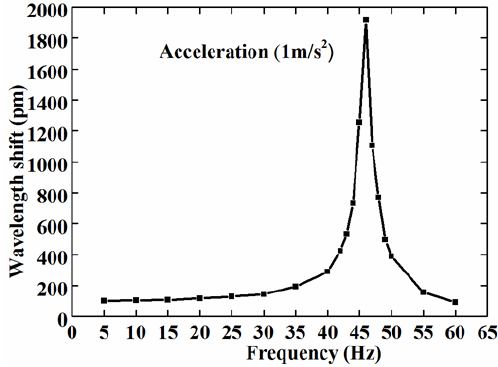
Figure 5. The frequency response of the accelerometer under acceleration of 1 m/s 2 .